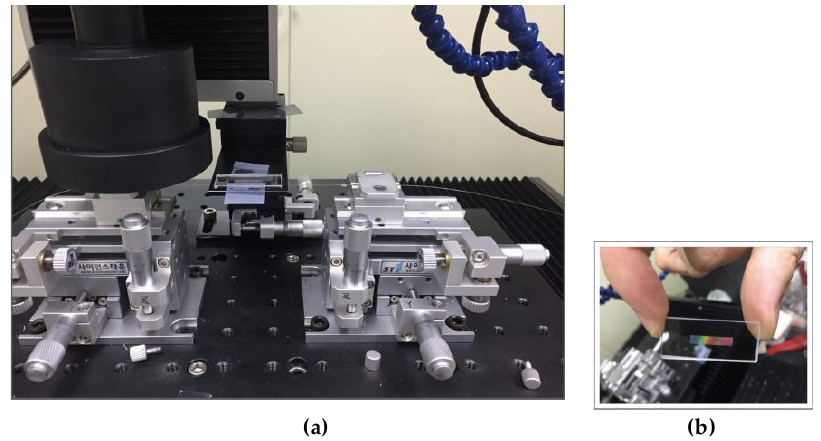
Figure 3. ( a ) A photorealistic view of processing Bragg gratings in a femtosecond laser precision processing stage using a phase mask. ( b ) Photograph of the phase mask (period: 2132 nm, type: uniform, spacing: 2 nm, size: 25 × 3 mm, illumination: 808 nm) used for femtosecond laser processing. Braiding Process